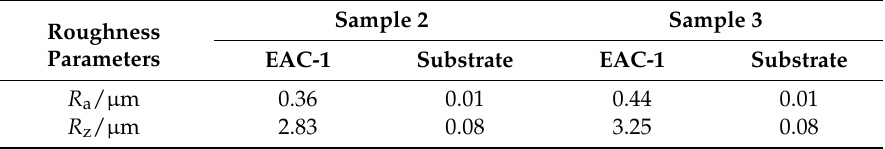
Table 5. Roughness parameters R a and R z of the deposited EAC-1 films and substrates.